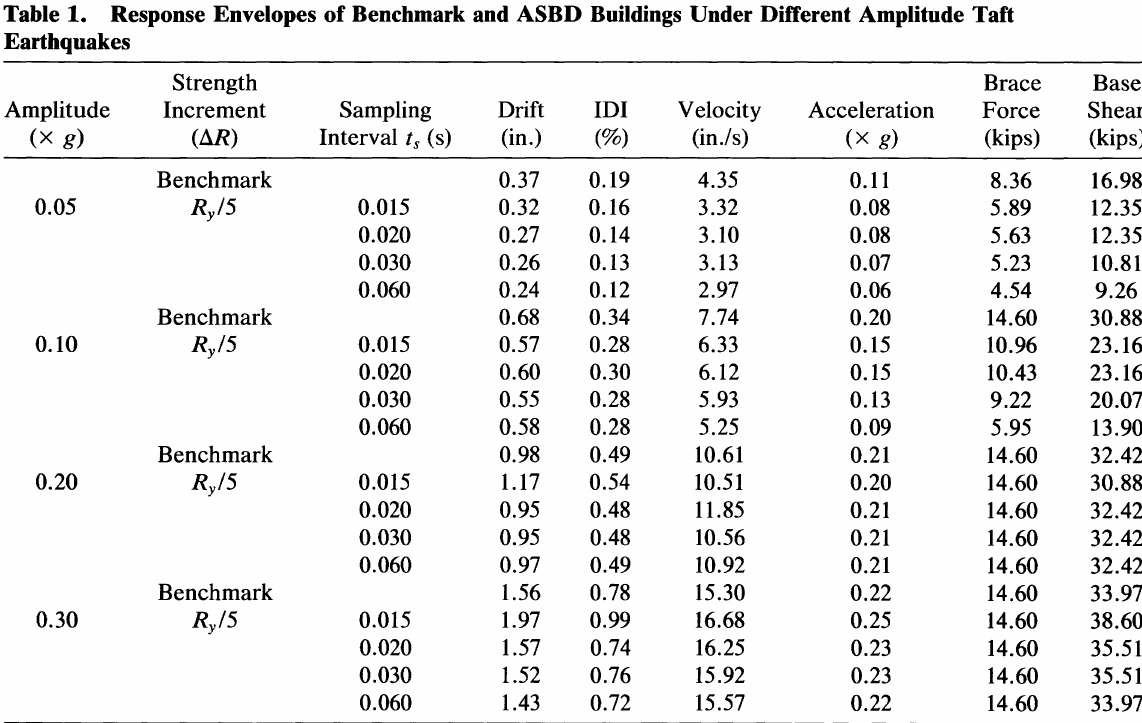
Table 1. Under excitations below or equal to the serviceability limit state corresponding to the 0.05 and 0.10 x g amplitude Taft earthquake, the ASBD building response is superior to that of the benchmark building. With increasing maximum amplitude of the Taft earthquake, the benchmark and ASBD building responses merge. Also